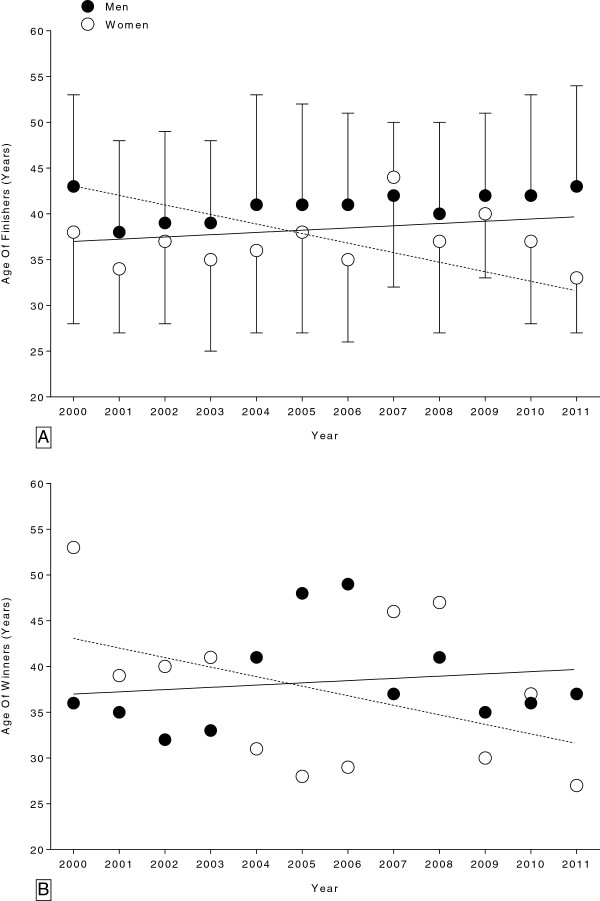
Changes in the age of all female and male finishers (Panel A) and for the annual winners (Panel B) in the ‘24 Stunden Schötz’ from 2000 to 2011.